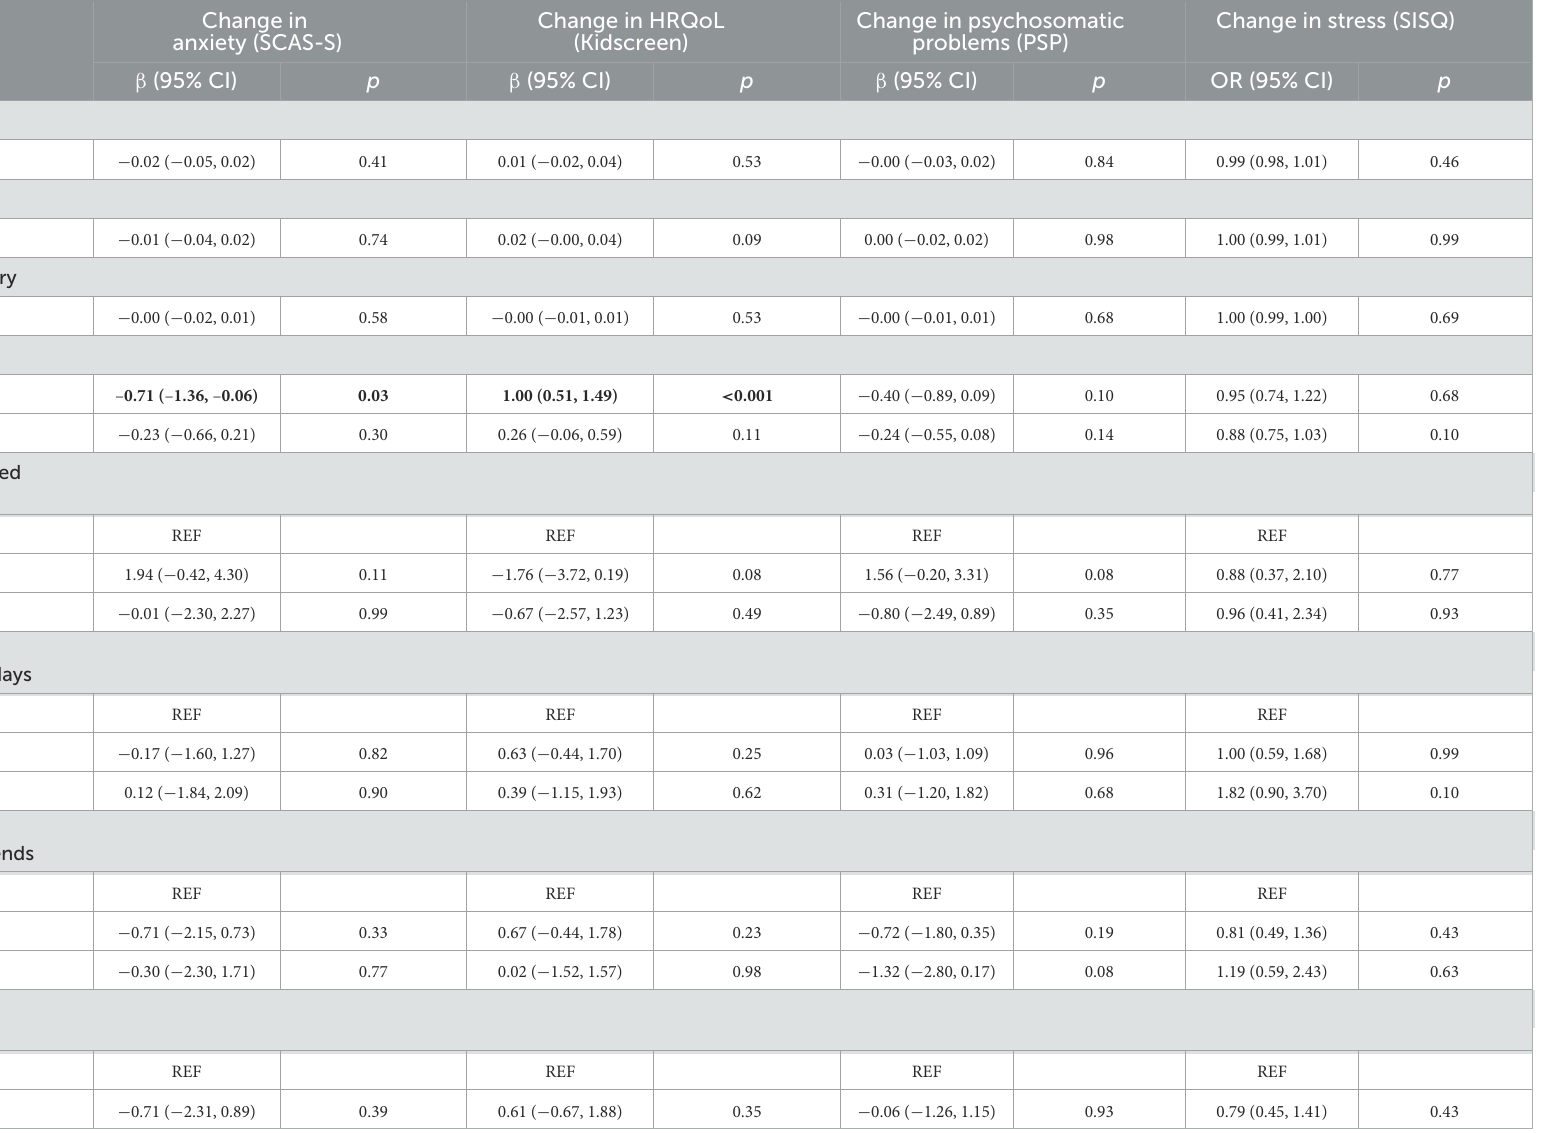
Change in stress